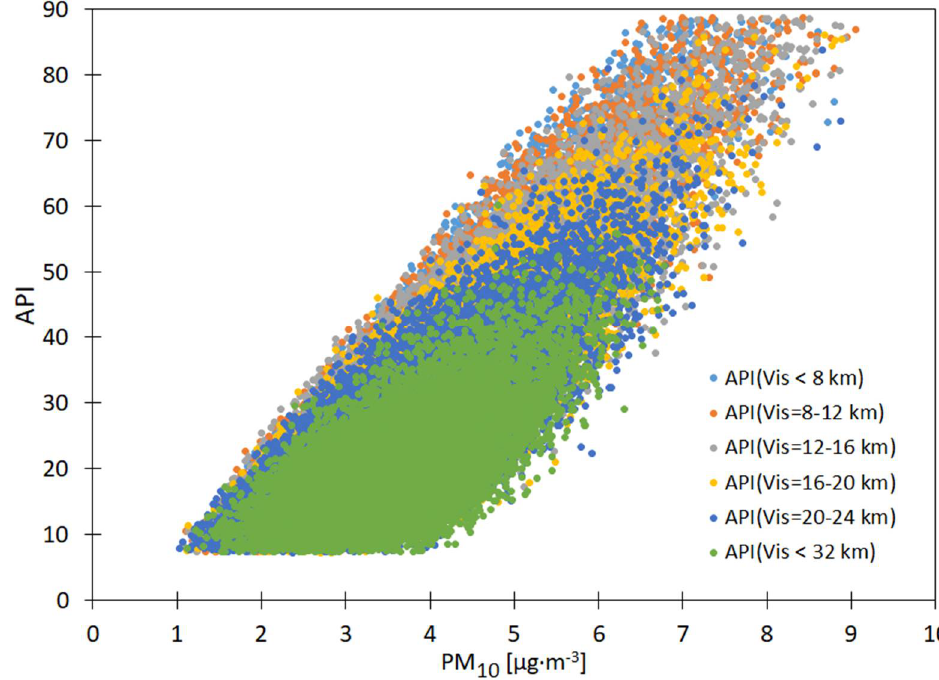
Figure A10. The effect of visibility-dependent PM 10 air concentrations on the air pollution index for the spring rainy season.